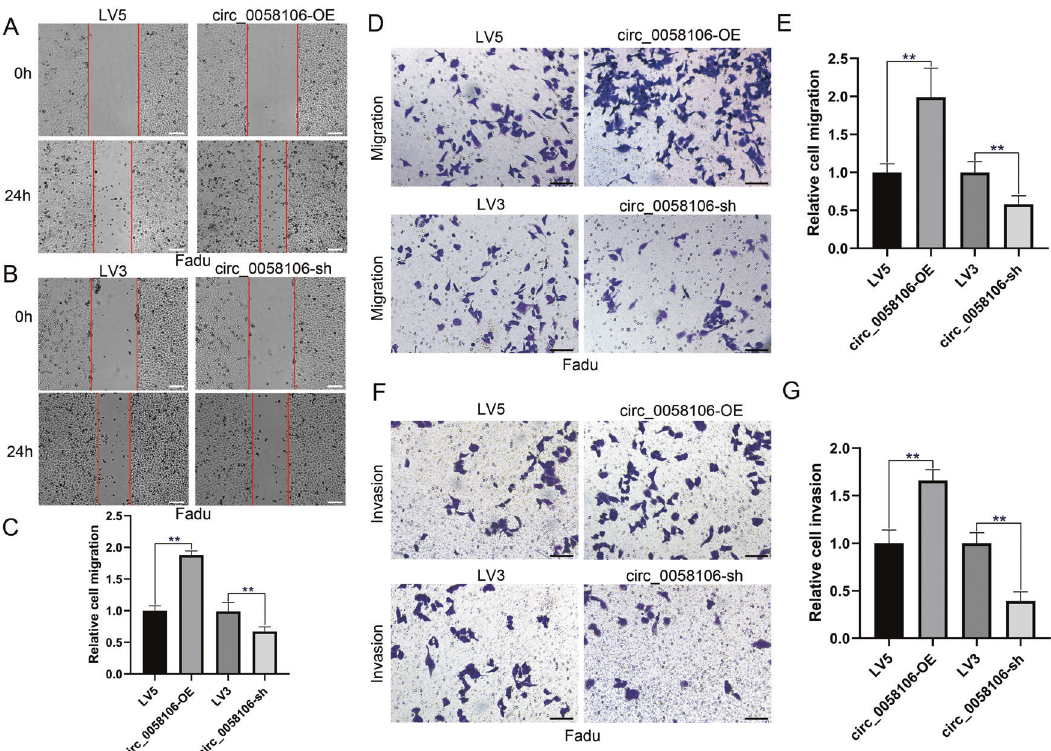
Fig. 3 circ_0058106 overexpression promotes migration and invasion of HSCC cells in vitro. A Migration of circ_0058106-OE and LV5 was measured by wound healing assay. (Scale bars = 200 μ m) B Migration of circ_0058106-sh and LV3 was measured by wound healing assay. (Scale bars = 200 μ m) C Quantitative analysis of wound healing assay. ( n = 3, * P < 0.05; ** P < 0.01) D Migration of circ_0058106-OE, LV5, circ_0058106-sh and LV3 Fadu cells was measured by transwell migration assay. (Scale bars = 100 μ m) E Quantitative analysis of transwell